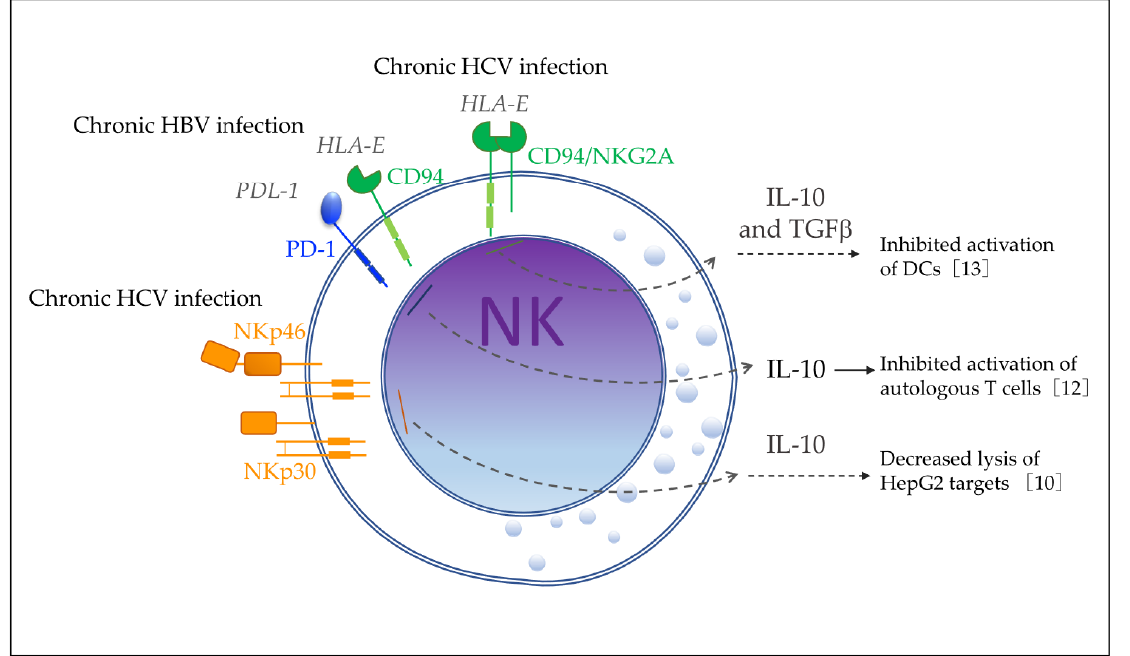
Figure 8. Figure shows the surface receptors associated with regulation of IL-10 production by NK cells and the potential effect on the host immune response in chronic viral diseases. HCV — hepatitis C virus; HBV — hepatitis B virus; DCs — dendritic cells; HepG2 — hepatic cell